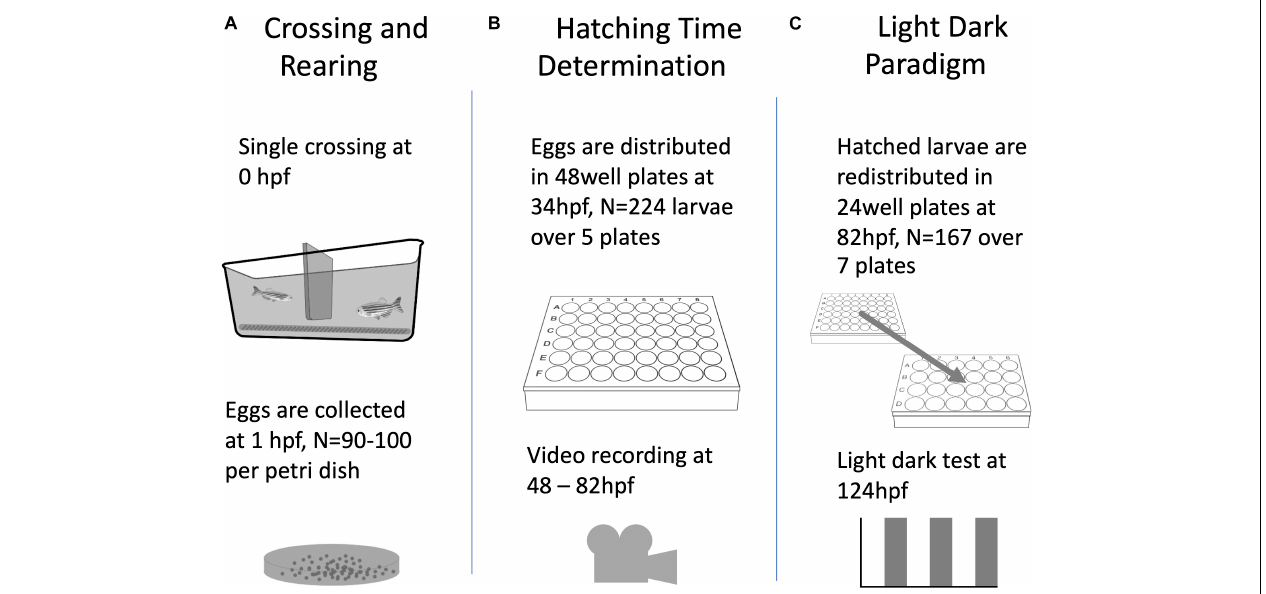
FIGURE 1 | A diagram of the general flow of the experimental procedures described in this paper, including the number of animals used per experiment.